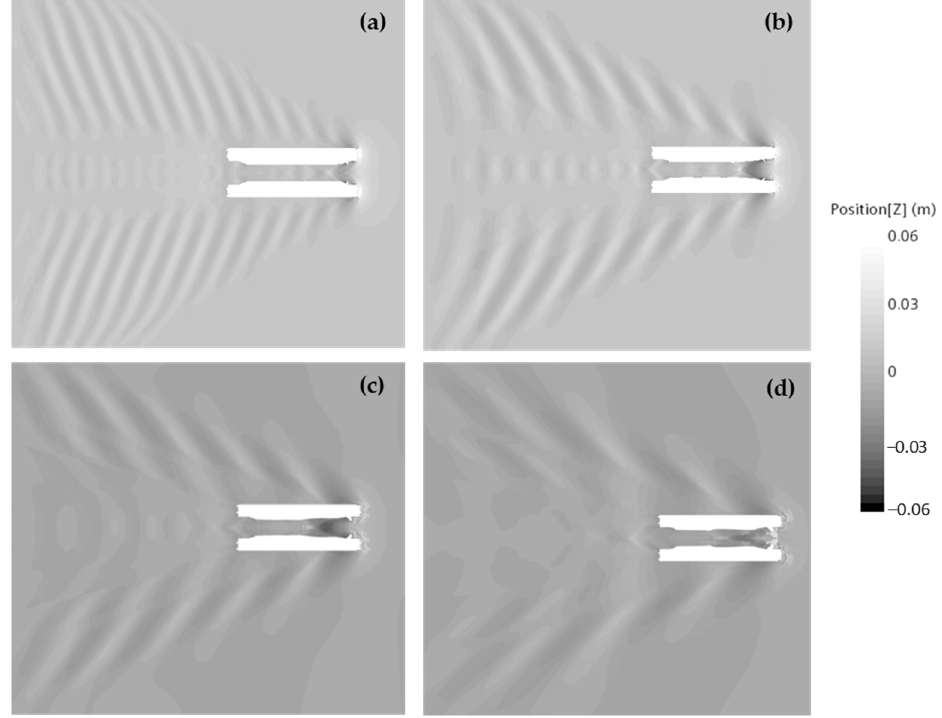
Figure 10. Wave pattern of amphibious vehicle w/caterpillars at Fn of: ( a ) 0.17, ( b ) 0.22, ( c ) 0.27, ( d ) 0.32.